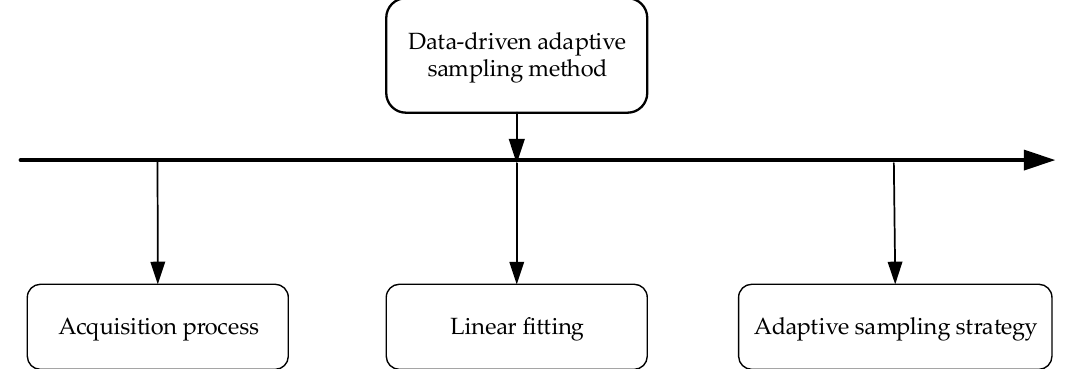
Figure 2. The process of data-driven adaptive sampling method.